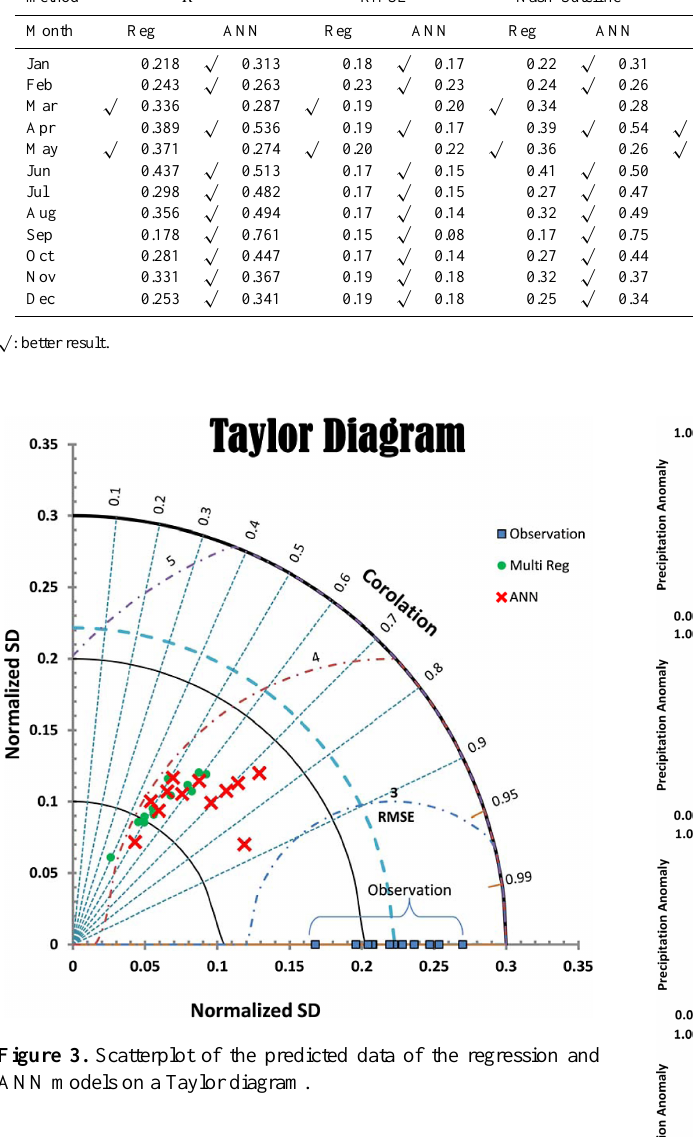
Table 9. Evaluation on the predicted results of the regression model and ANN model. Factor \ method